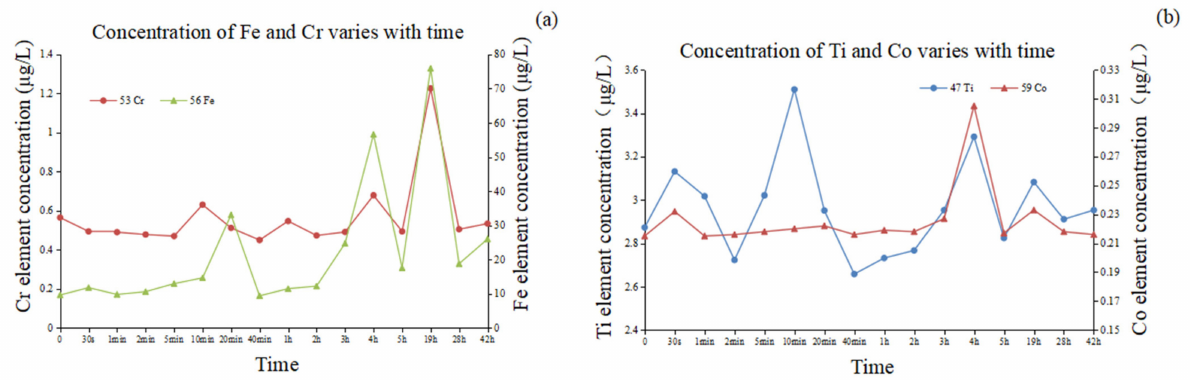
Figure 9. In conventional treatment water the effects of suspended particulate matter at different time adsorption and release of Fe and Cr ( a ); Ti and Co ( b